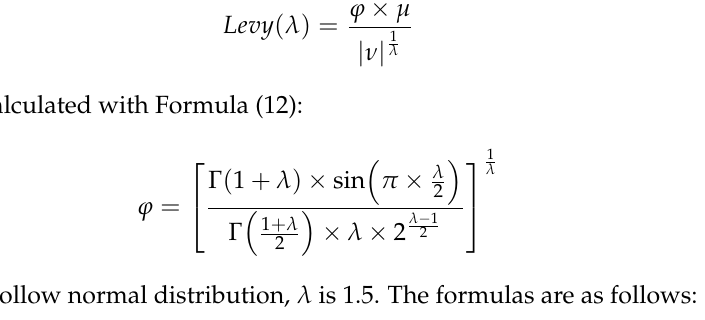
Figure 2. Change of step size factor